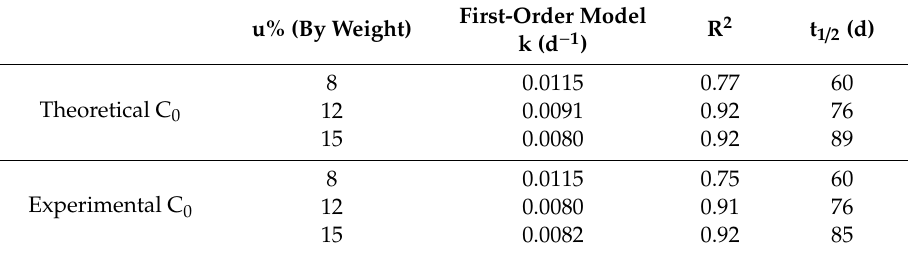
Table 5. First-order reaction rate constants and half-life times for microcosms with C / N = 120.